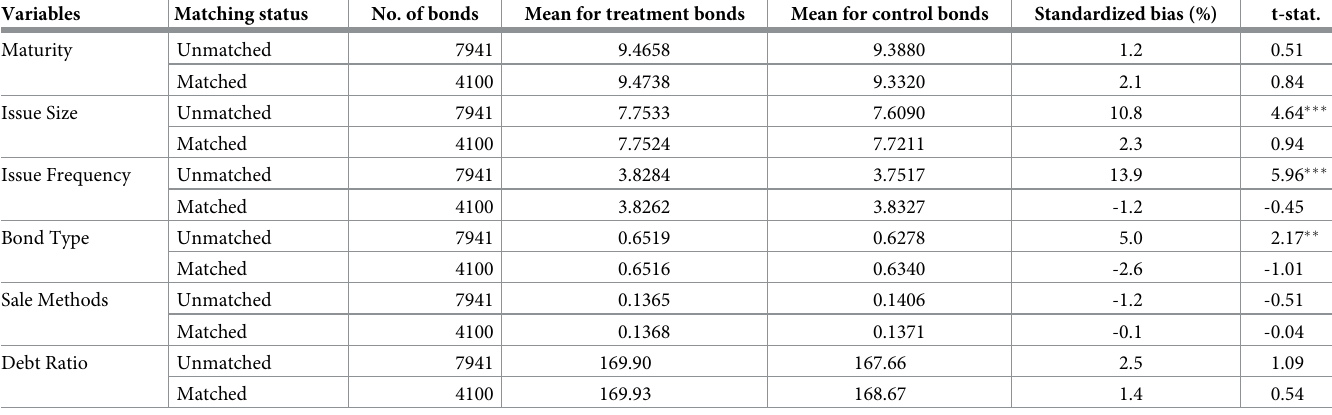
Table 10. Univariate tests of covariate balance for propensity-score matching. This table reports descriptive statistics of the covariates for the sample of treatment bonds and the sample of control bonds. The results of the two-sample tests of mean and of the standardized bias for the covariates are provided for both unmatched and matched